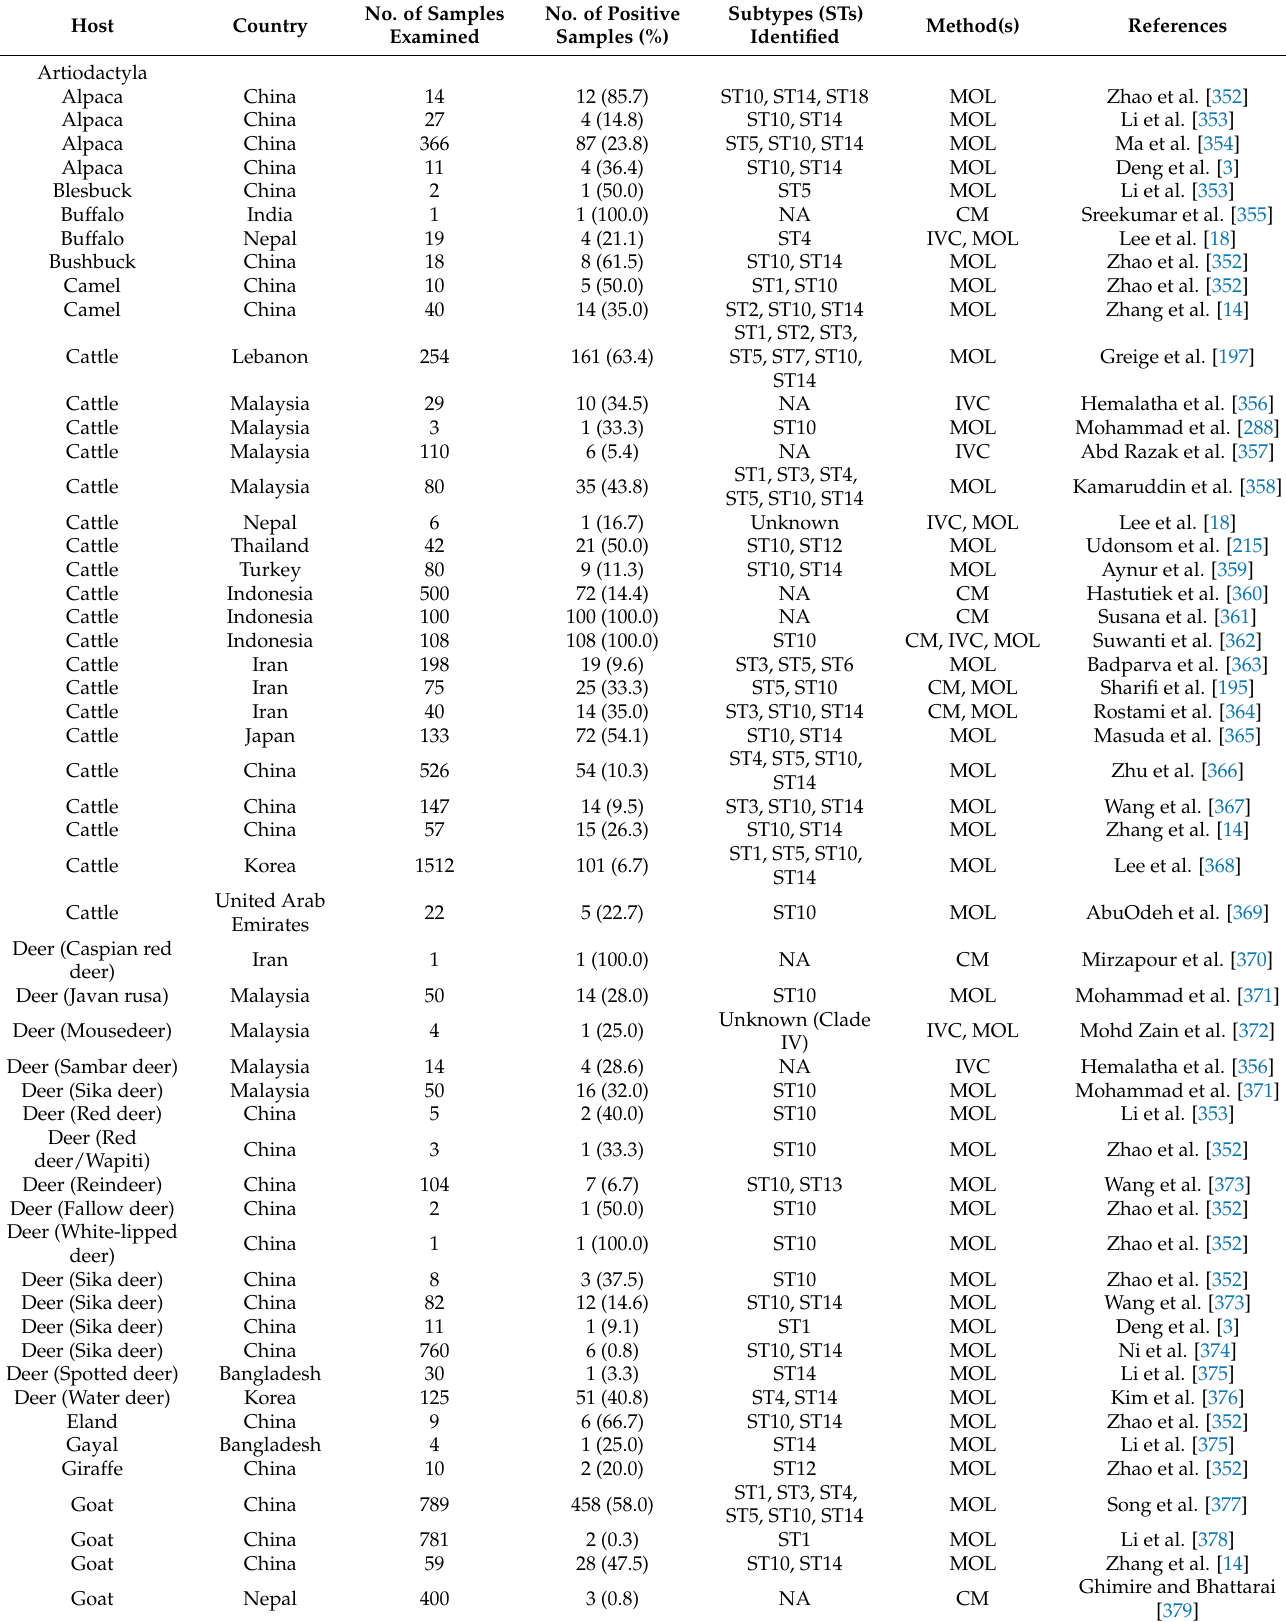
Table 9. Prevalence and subtype distribution of Blastocystis spp. in ungulates in Asia